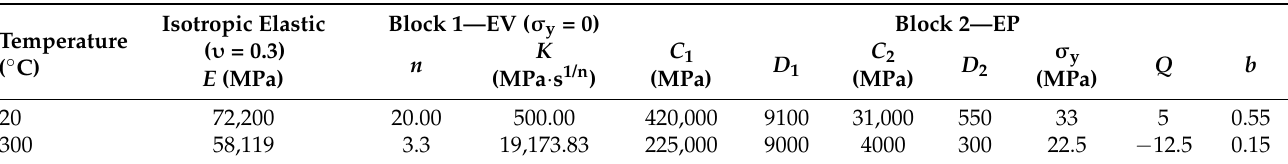
Table 4. Elastic and LM&C parameters used for modelling the mechanical behavior of